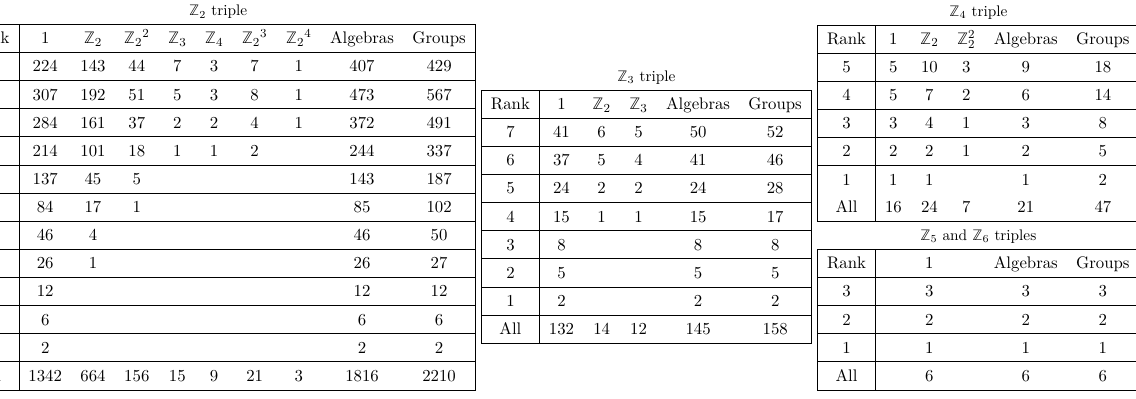
Table 3 . Number of algebras and groups of each rank with a certain fundamental group for the heterotic Z 2 , Z 3 , Z 4 , Z 5 and Z 6